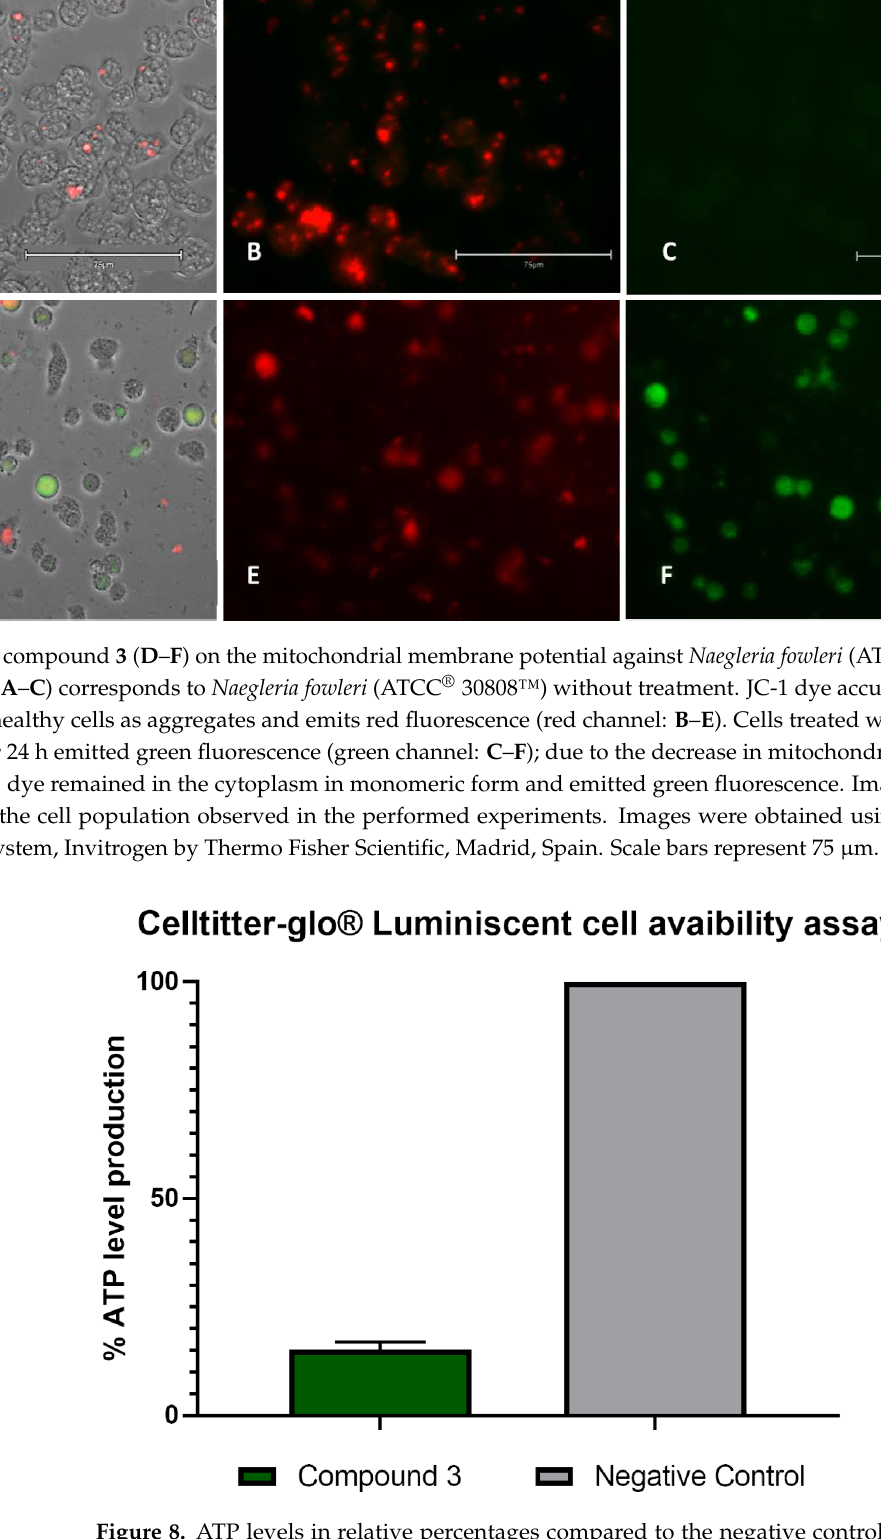
Figure 8. ATP levels in relative percentages compared to the negative control in Naegleria fowleri (ATCC ® 30808™) trophozoites after 24 h of incubation with IC 90 of the evaluated compound. Error bars represent the standard deviation (SD). Each data point indicates the average of the results of three measurements. The results show a decrease in the ATP level following treatment with compound 3 of 84.90% compared to the negative control (cells without treatment).